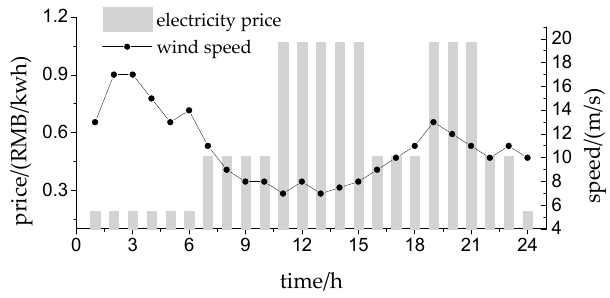
Figure 5. The curves of electricity price and forecast wind speed.